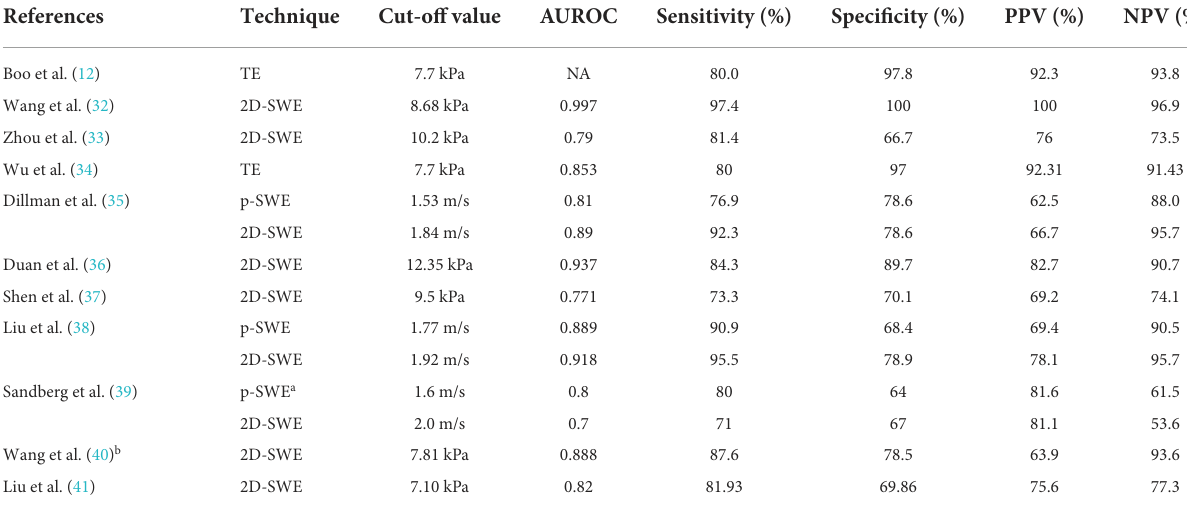
TABLE 4 Summary of diagnostic accuracy of ultrasound elastography for BA.